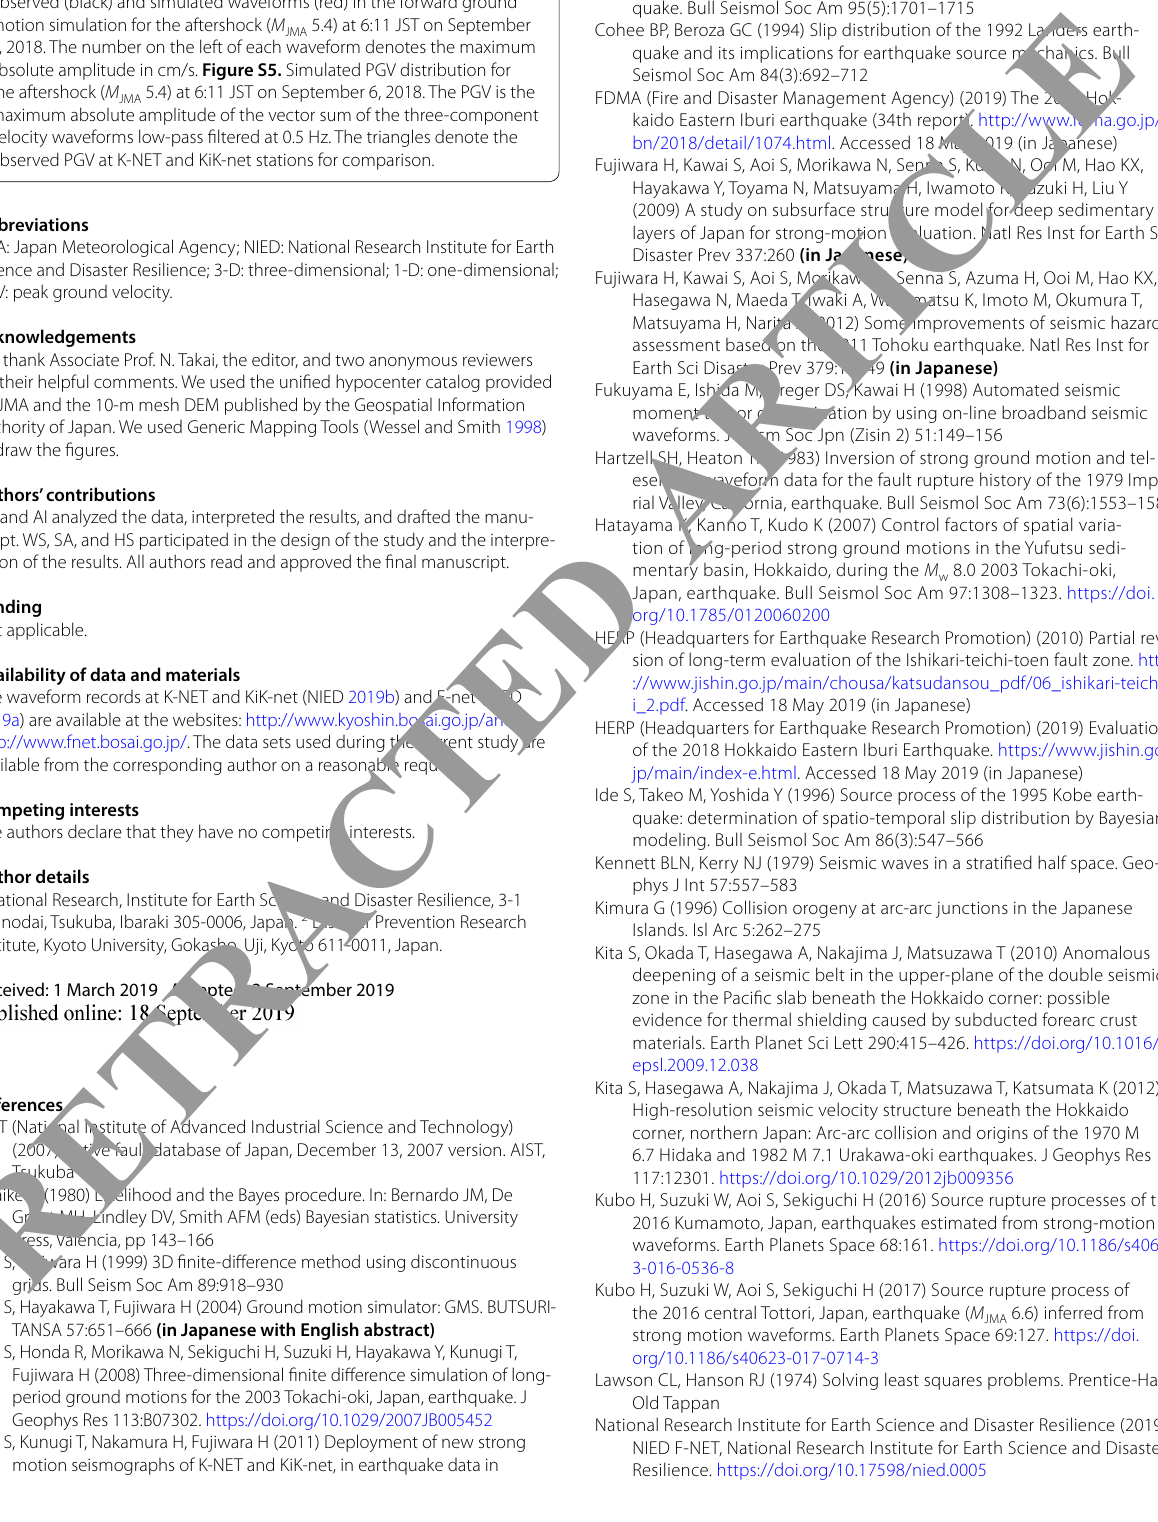
Hidaka Mountains and the source fault. Figure S4. Comparison between observed (black) and simulated waveforms (red) in the forward ground motion simulation for the aftershock ( M JMA 5.4) at 6:11 JST on September 6, 2018. The number on the left of each waveform denotes the maximum absolute amplitude in cm/s. Figure S5. Simulated PGV distribution for the aftershock ( M JMA 5.4) at 6:11 JST on September 6, 2018. The PGV is the maximum absolute amplitude of the vector sum of the three-component velocity waveforms low-pass filtered at 0.5 Hz. The triangles denote the observed PGV at K-NET and KiK-net stations for